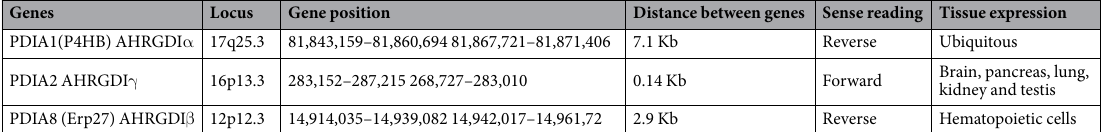
Table 1. Gene location and main tissue expression of PDI and RhoGDI pairs addressed in the present study.